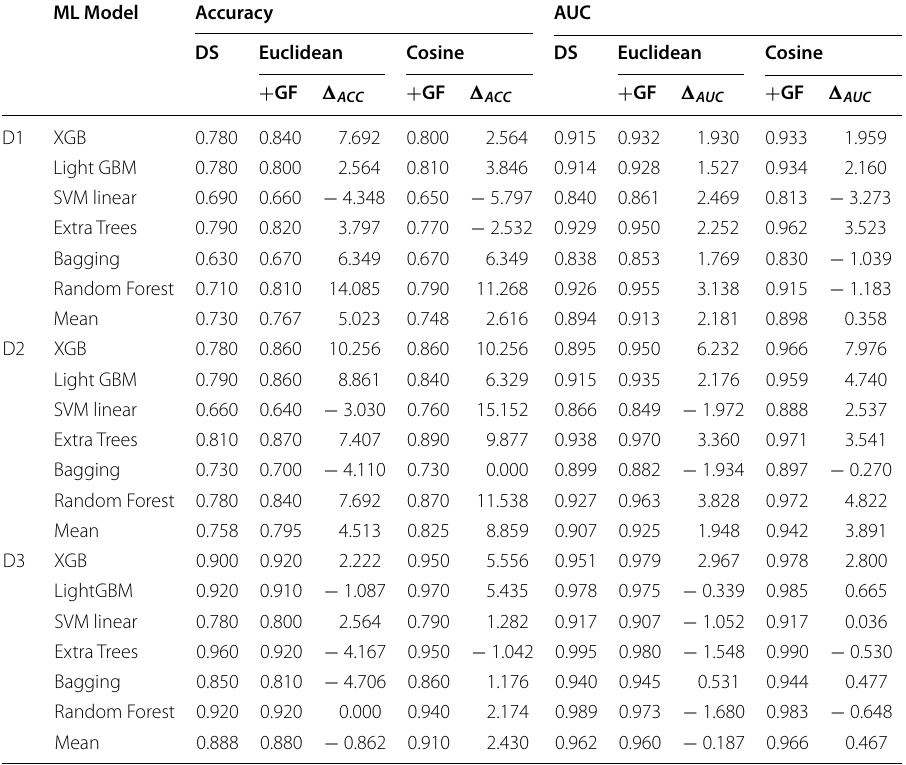
Table 5 Classification performance when employing DS only and combining DS and GF for datasets D 1, D 2, and D